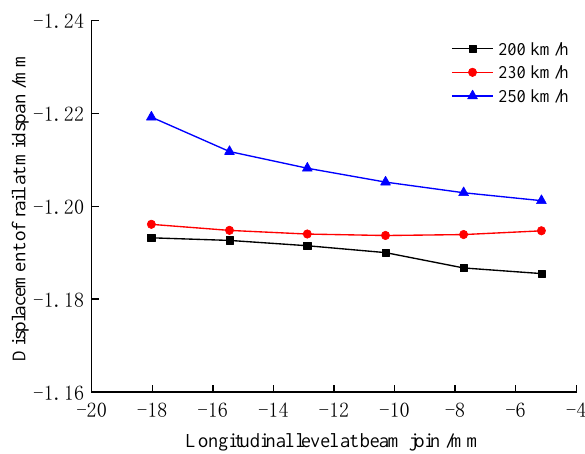
Figure 22. Displacement of rail at midspan.